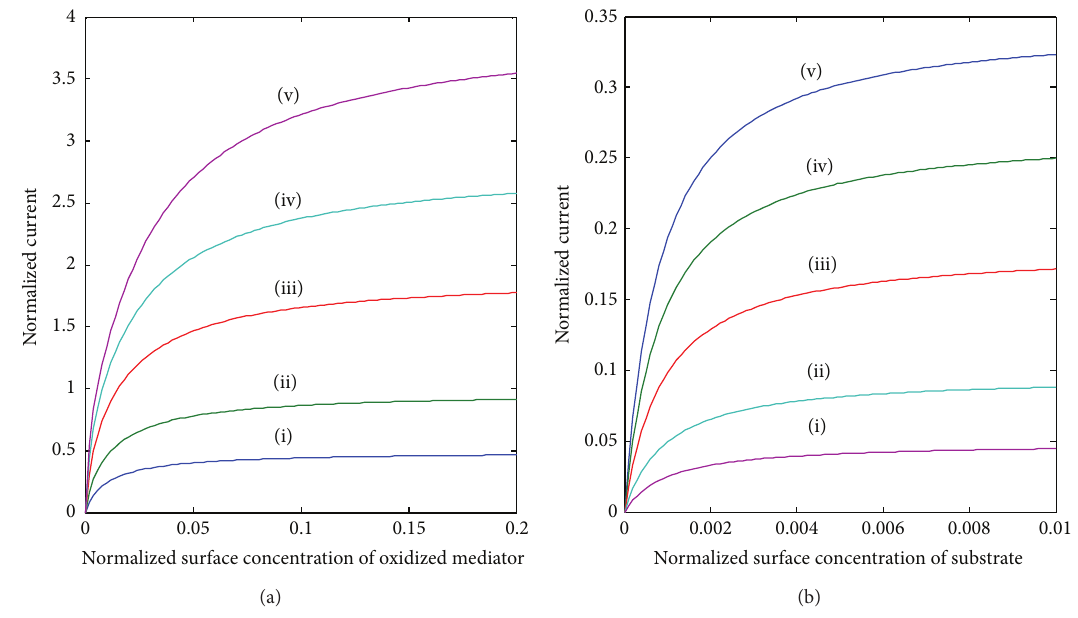
and (b) normalized surface O = 100 ( 𝑑 = 78.80 𝜇 M) O